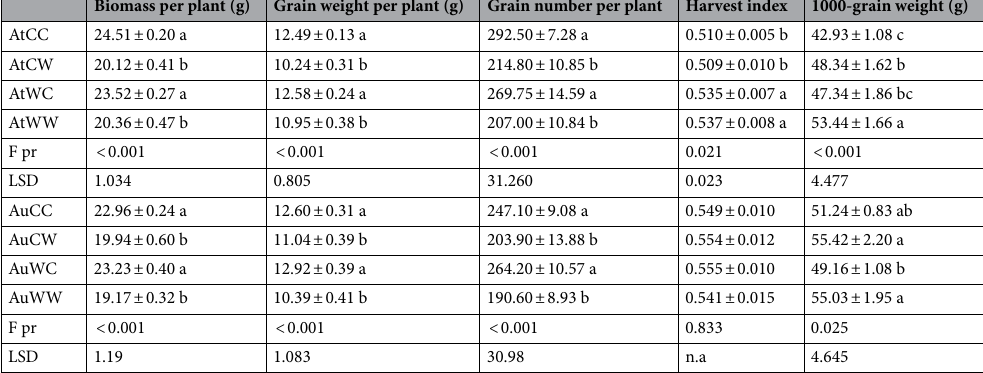
Table 1. Effect of transgenerational water stress on yield components measured at harvest for two durum wheat genotypes. Means ± SE for n = 10 are shown for each trait. Different letters (a, b, c) denote statistically significant differences among treatment groups within each genotype, using least significant difference (LSD) when P < 0.05. The treatment groups are: AtCC (DBA Artemis control group parents, progeny treated with control), AtCW (DBA Artemis control group parents, progeny treated with water-deficit stress), AtWC (DBA Artemis water-deficit stress group parents, progeny treated with control), AtWW (DBA Artemis water-deficit stress group parents, progeny treated with water-deficit stress); AuCC (DBA Aurora control group parents, progeny treated with control), AuCW (DBA Aurora control group parents, progeny treated with water-deficit stress), AuWC (DBA Aurora water-deficit stress group parents, progeny treated with control), AuWW (DBA Aurora water-deficit stress group parents, progeny treated with water-deficit stress).